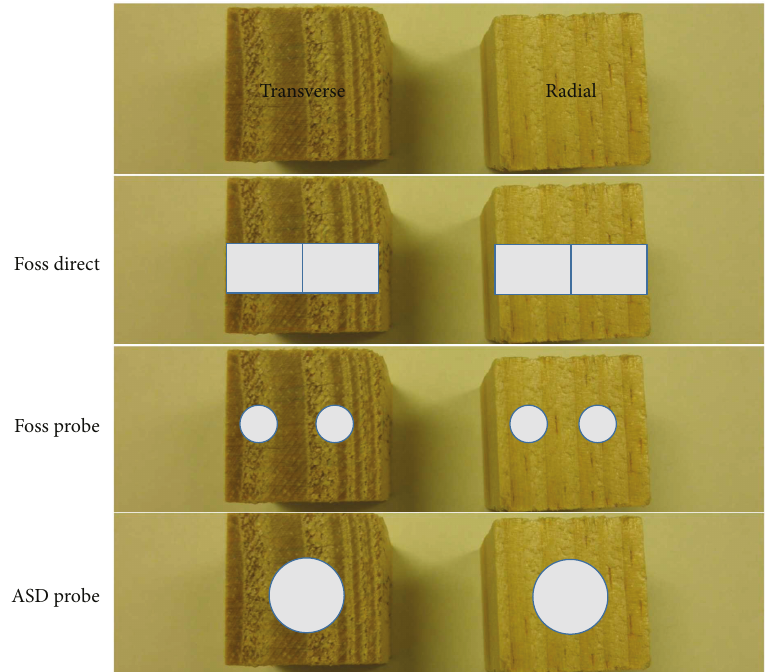
Figure 3: A typical pine sample utilized in this study. NIR spectra were collected from the transverse and radial faces, with the approximate areas examined for the di ff erent methods (Foss Direct, Foss Probe, and ASD Probe) employed for obtaining spectra highlighted. Table 4: Summary information (average, standard deviation, maximum, and minimum) for density, modulus of elasticity (MOE), and modulus of rupture (MOR) values for each of the six pine species utilized in this study. One species, Pinus caribaea , included three varieties. Density (12%) Species Samples tested